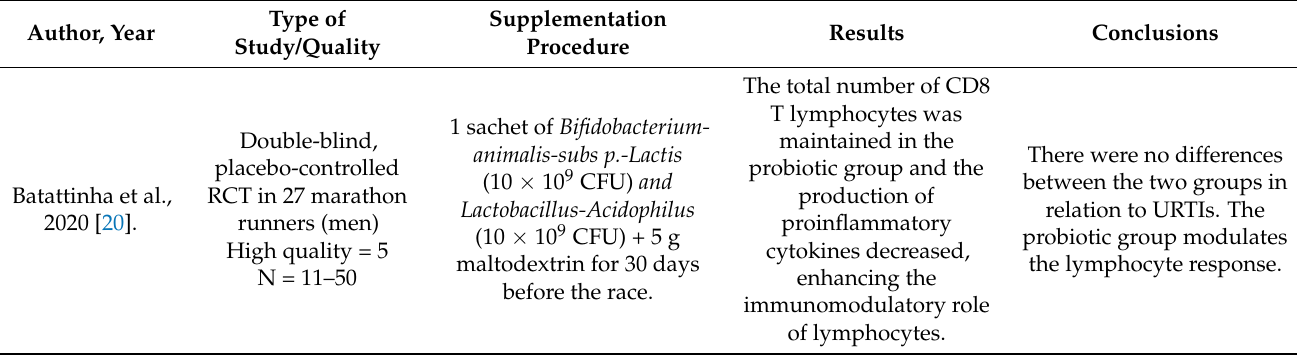
Table 2. Characteristics and main results of clinical trials on the use of probiotics in endurance athletes and improvement of sports